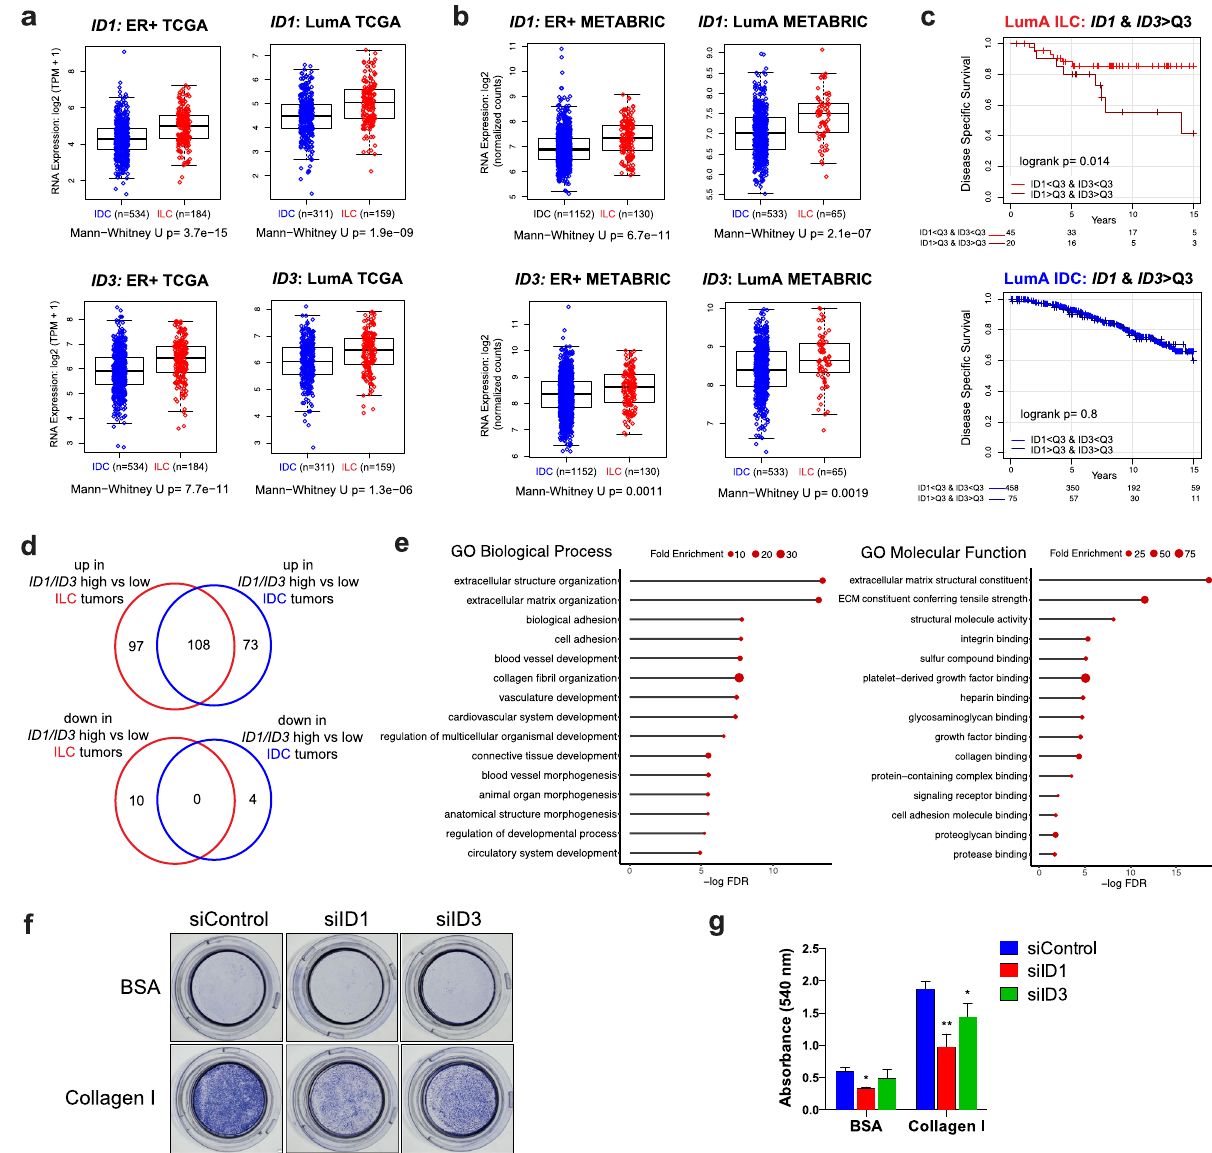
Figure 7. ID1 and ID3 expression and function in human breast tumors. ( a , b ) mRNA levels of ID1 (top) and ID3 (bottom) in ER-positive (left) and LumA (right) ILC (red) and IDC (blue) tumors from the ( a ) TCGA and ( b ) METABRIC cohorts. p-values are from Mann–Whitney U test. ( c ) Disease-specific survival curves for combined ID1 and ID3 expression in Luminal A ILC (top) and IDC (bottom) patients from the METABRIC cohort divided by third quartile (Q3) levels. p-values are from log-rank test. ( d ) Venn diagrams of genes upregulated (top) and downregulated (bottom) in ID1/ID3 high versus low tumors in the ILC (red) and IDC (blue) cohorts from the Kaplan Meier plots in ( c ). ( e ) Gene Ontology (GO) Biological Process (left) and Molecular Function (right) terms enriched in the 97 ILC-only upregulated genes from ( d ). ( f , g ) Images ( f ) and quantification ( g ) of crystal violet-stained BSA and Collagen I inserts from haptotaxis assays in SUM44 cells transiently transfected with the indicated siRNAs. p-values are form ordinary one-way ANOVA with Dunnett multiple comparison test to siControl. *p ≤ 0.05; **p ≤